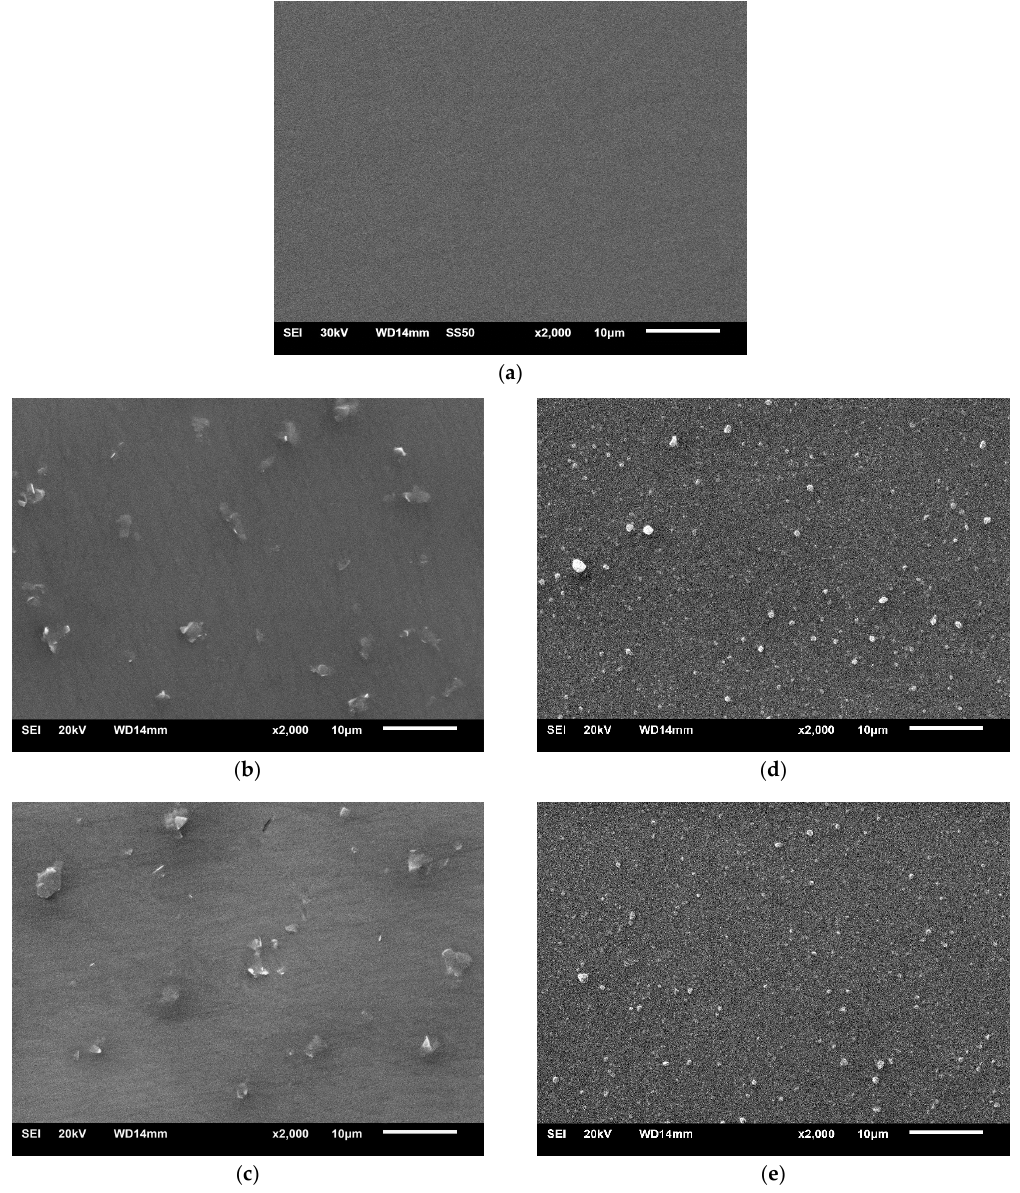
Figure 1. Scanning electron microscope (SEM) images of Al 2 O 3 and Al 2 O 3 + graphene coatings with 1% of graphene in sol suspension: ( a ) Al 2 O 3 coating heat treated at 500 °C; ( b ) Al 2 O 3 + G1 coating dried at ambient temperature; ( c ) Al 2 O 3 + G1 coating heat treated at 500 °C; ( d ) Al 2 O 3 + G2 coating dried at ambient temperature; ( e ) Al 2 O 3 + G2 coating heat treated at 500 °C.